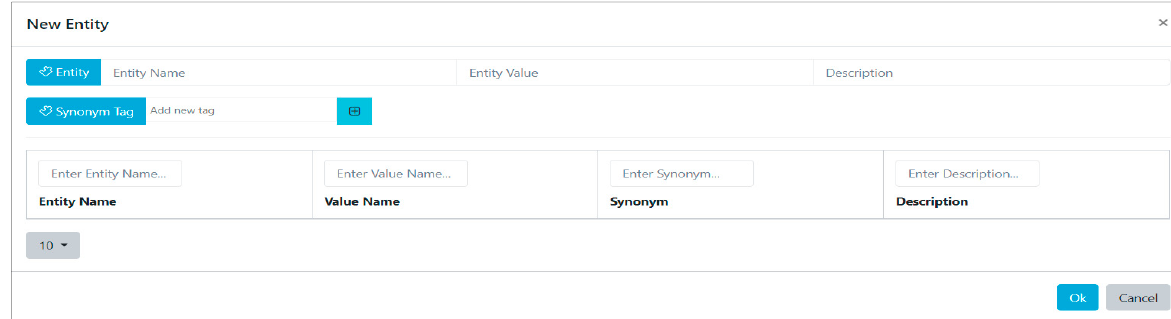
Figure 12. Input interface of chatbot Entity data.